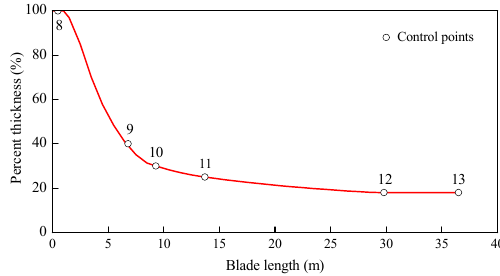
Figure 3. Percent thickness distribution of the blade.